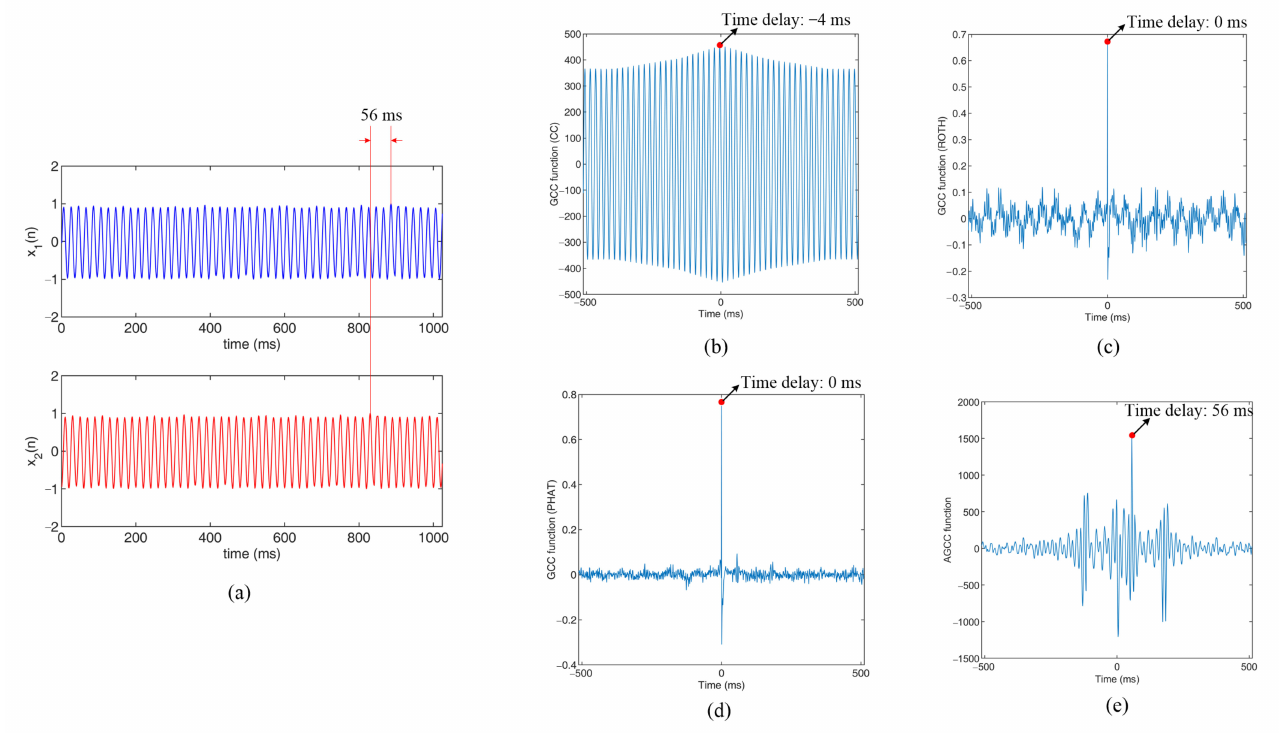
Figure 8. Results of the simulation experiments with A m = 100 and RE = 85.6: ( a ) original signals; ( b ) cross-correlation functions obtained by CC; ( c ) cross-correlation functions obtained by GCC with Roth; ( d ) cross-correlation functions obtained by GCC with PHAT; ( e ) cross-correlation functions obtained by